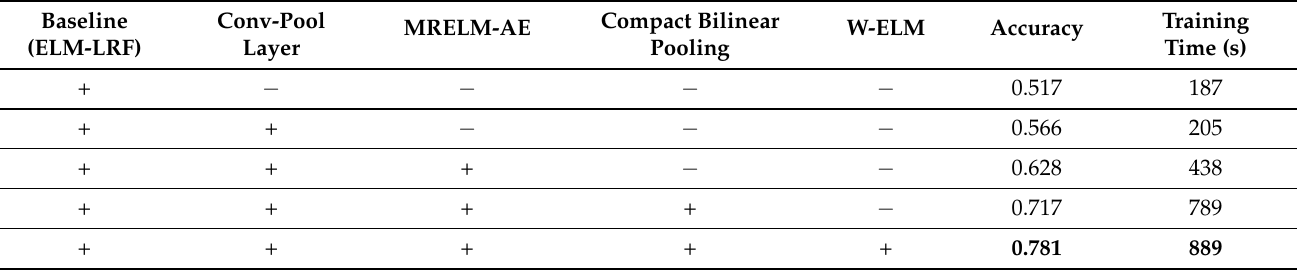
Table 4. Ablation study on the components of the bilinear discriminative ELM network. The bold numbers represent the optimal detection result.